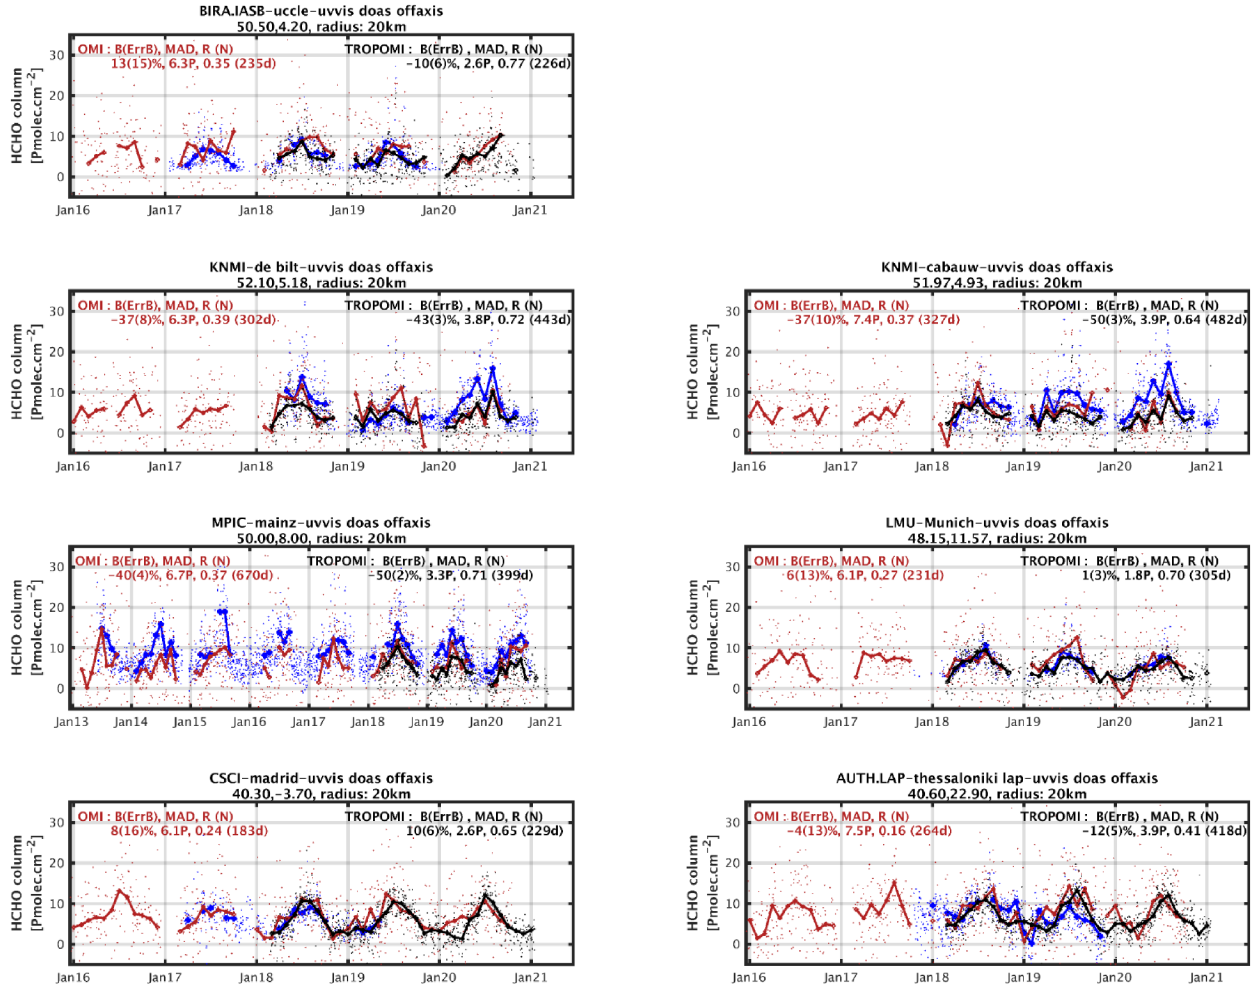
Figure 12. Time series of MAX-DOAS HCHO columns (blue), OMI N v_clear (red) and TROPOMI N v_clear (black) at European sites. Thick lines show monthly median values, and dots represent daily median values. Mean relative bias, median absolute deviations and correlations between the time series are provided for the daily averaged data. (Pmolec.cm − 2 = 10 15 molec.cm − 2